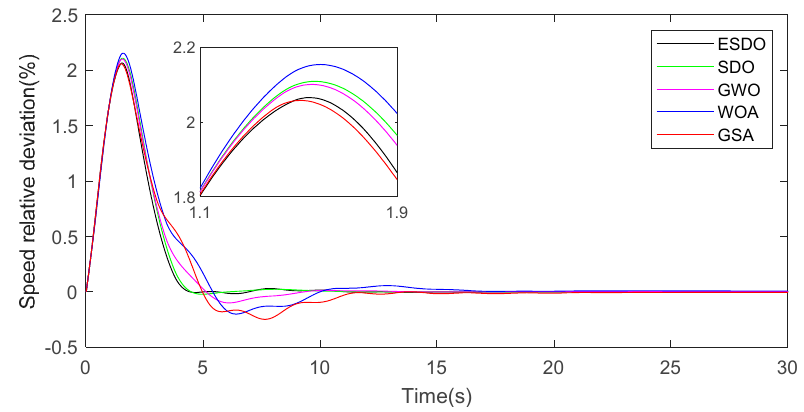
Figure 20. Speed response curves with 16% load.